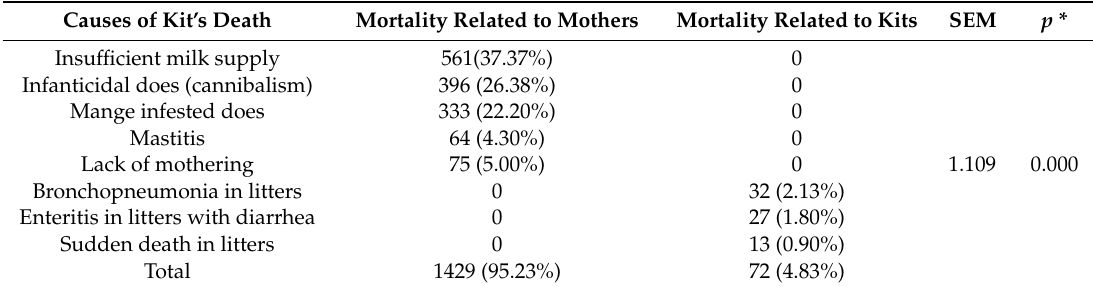
Table 1. Managemental causes of preweaning mortality related to mothers and kits.